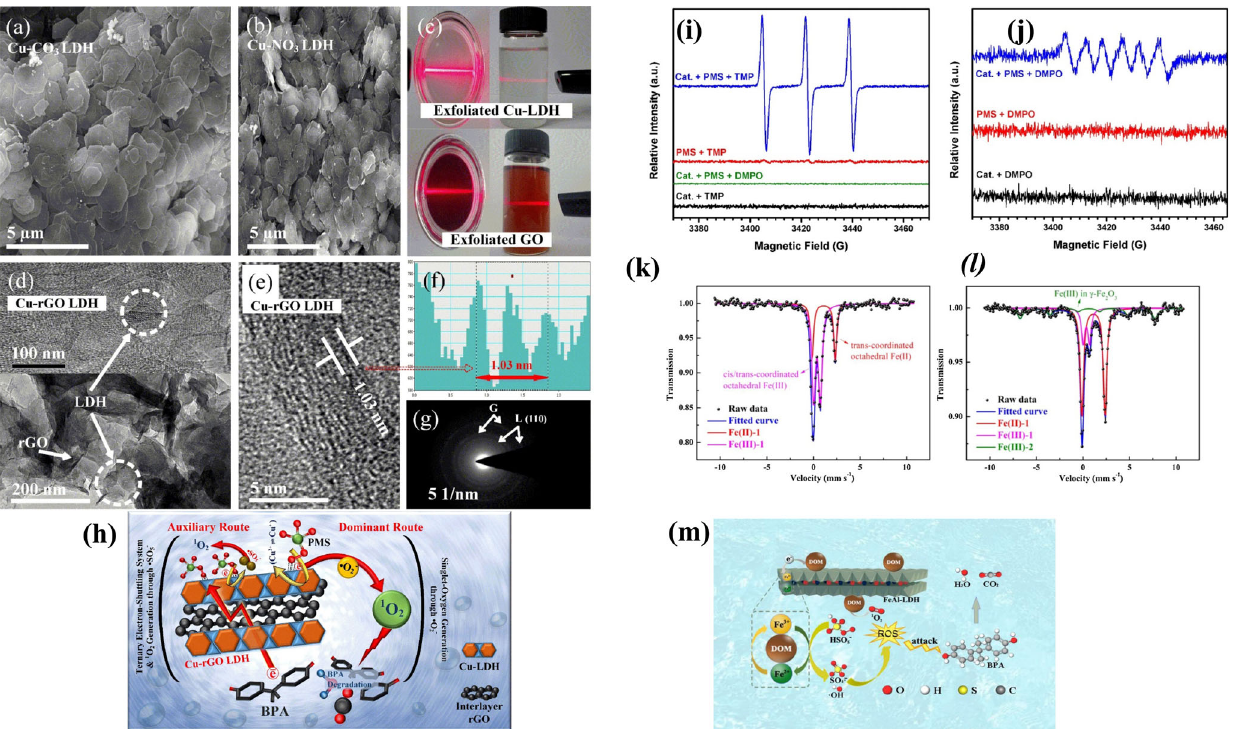
Fig. 3 Morphology characterization of LDHs and identi fi cation of the controlled ROS on the PMS activation. a , b SEM images of Cu-rGO LDH, c Tyndall light scattering effect, d , e TEM of Cu-rGO LDH, f , g SAED of Cu-rGO LDH, h the mechanism of 1 O 2 formation in the Cu-rGO LDH/ and k , l Fe Mössbauer spectra FeAl-LDH and DOM-LDH, and m the proposed PMS system, i , j ESR spectra of TMP- 1 O 2 and DMPO- O (cid:1)(cid:3) 2 degradation mechanism adapted with permission from ref. 115 Copyright, 2020,